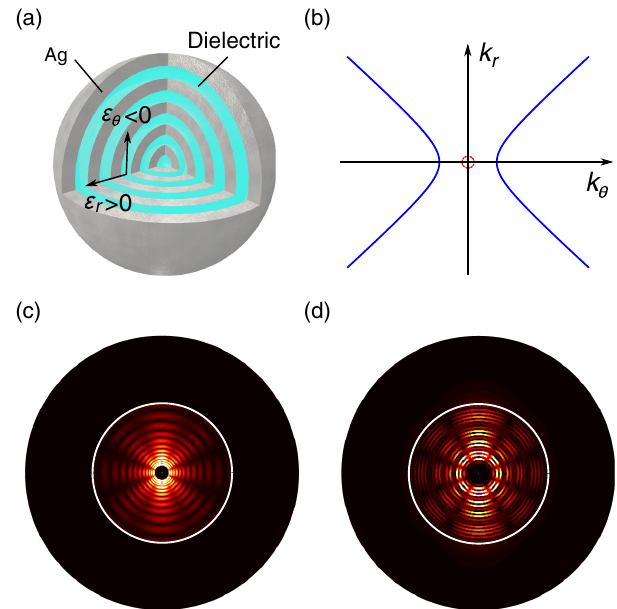
FIG. 1. (a) A schematic of the hyperbolic cavity composed of alternating metal and dielectric layers. (b) The isofrequency contour (solid line) in the momentum space calculated with the effective medium approximation with λ ¼ 1000 nm. The small dotted circle at the center represents the isofrequency contour in vacuum at the same wavelength. A whispering-gallery resonance supported by (c) a homogeneous hyperbolic cavity and (d) a multilayer structure with l ¼ 4 . The cavity in (c) has an inner radius of 20 nm and an outer radius of 200 nm, with the resonant wavelength being λ ¼ 992 nm. The cavity in (d) is composed of 20 functional layers with a thickness of 10 nm for each. The resonant wavelength in (d) is λ ¼ 977